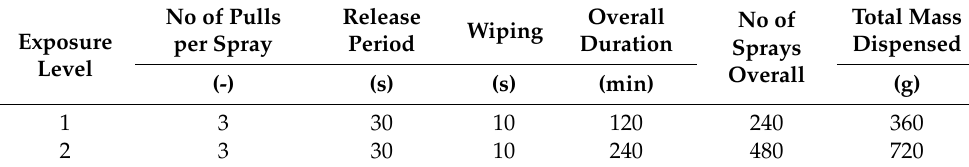
Table 6. Test procedure settings for exposure to manual spray-sanitization.